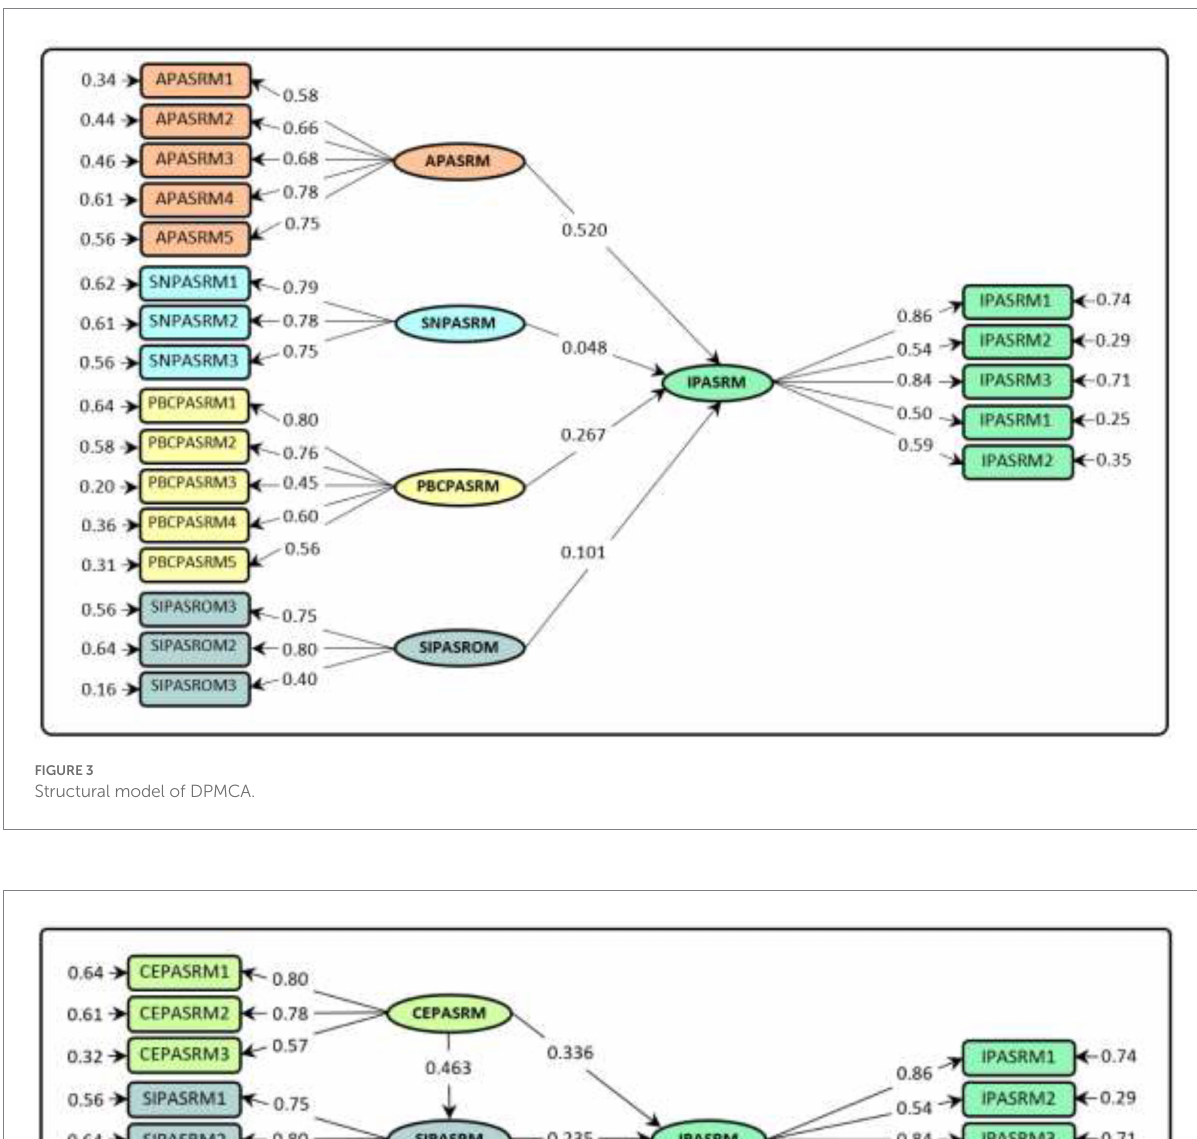
FIGURE 4 Structural model of